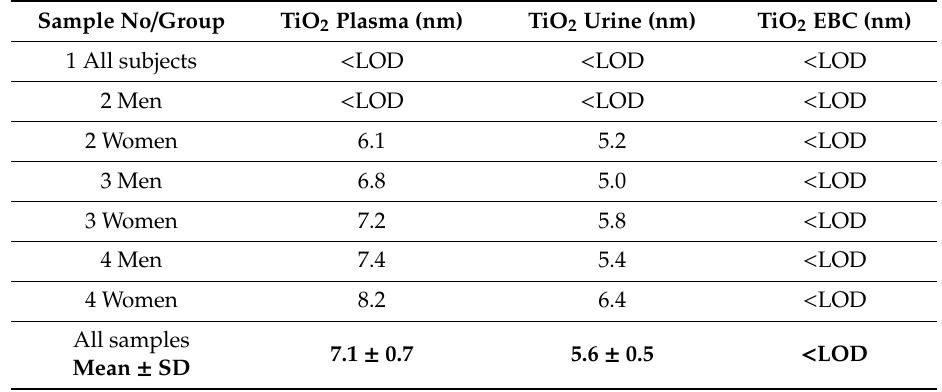
Table 5. Particle size distribution (PSD) of TiO 2 measured in plasma, spot urine, and exhaled